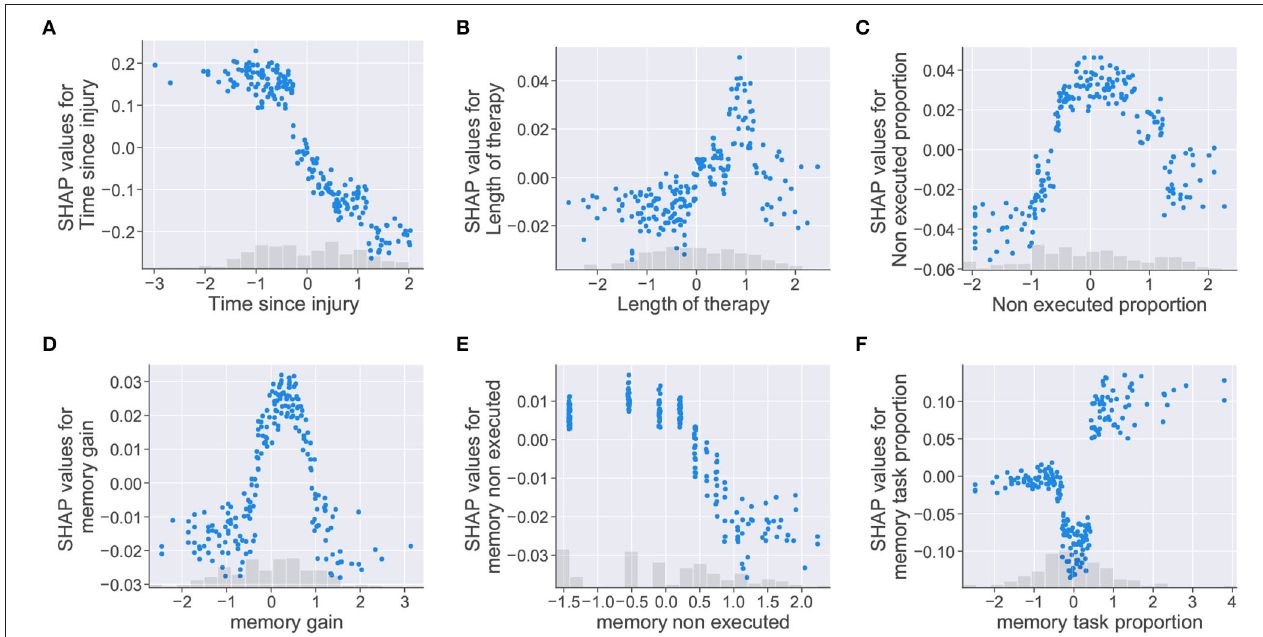
FIGURE 7 | Dependence scatter plots showing the effect of six input features in the model predictions. SHAP values (y-axis) pushes the outcome toward a class “0” (no cognitive improvement, negative SHAP values) or a class “1” (cognitive improvement, positive SHAP values). Normalized instances of features with corresponding histograms depicted in the x-axis. (A) Time since injury, (B) Length of therapy, (C) Non executed proportion, (D) memory gain, (E) memory non executed, and (F) memory task proportion.